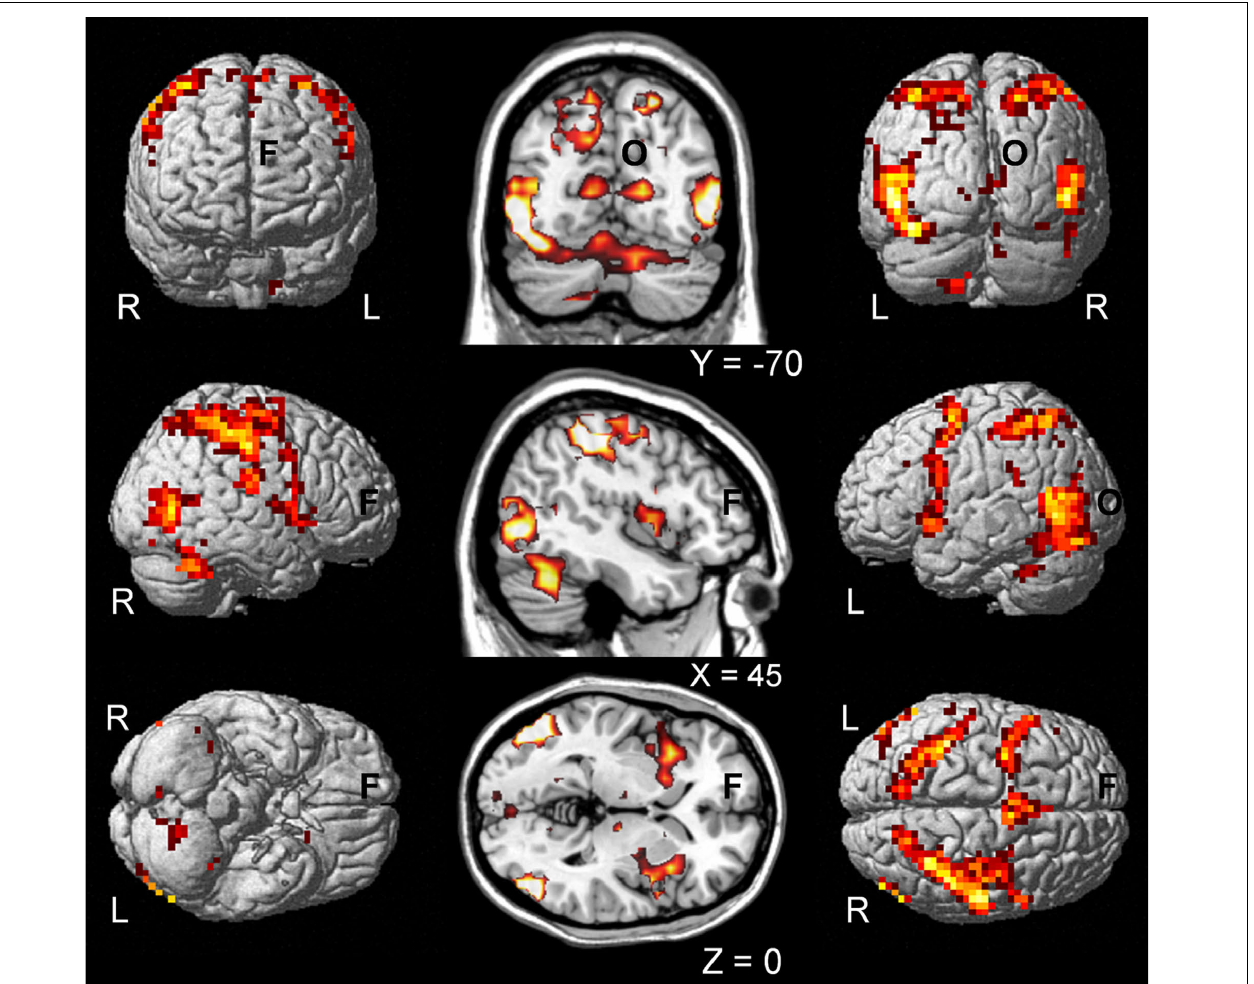
the individual judgment of causality. Activation maps are presented of single subjects render brain of SPM (left and right) and on coronal, sagittal and axial slices of a template brain (middle; MRIcro). L, left; R, right; F, frontal; O,